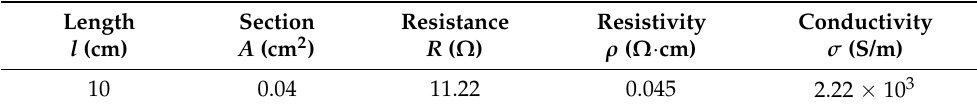
Table 3. Characterization of the Electrifi material.